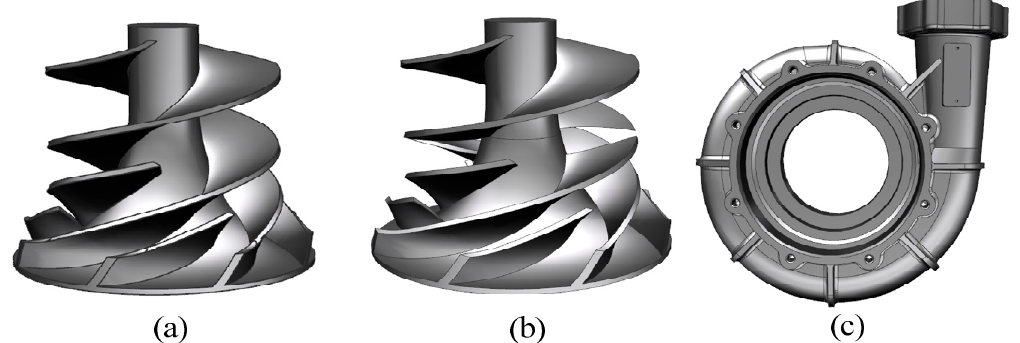
Figure 4. 3-D models: ( a ) a combination impeller; ( b ) a conventional impeller; ( c ) and a